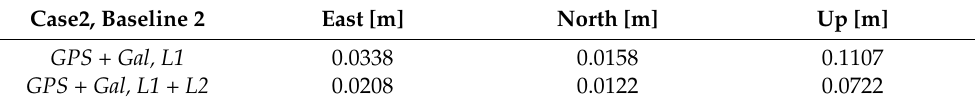
Figure 15. Comparison of positioning performance of single- vs. dual-frequency GPS + Galileo solutions for Case 1, baseline 1. Top: 3D positioning error. Bottom: horizontal positioning—the true position of the rover station is (0,0). Table 9. Standard deviation from known position in the east, north, and up direction for PPK solutions using GPS + Galileo and one or two frequencies in Case 2, baseline